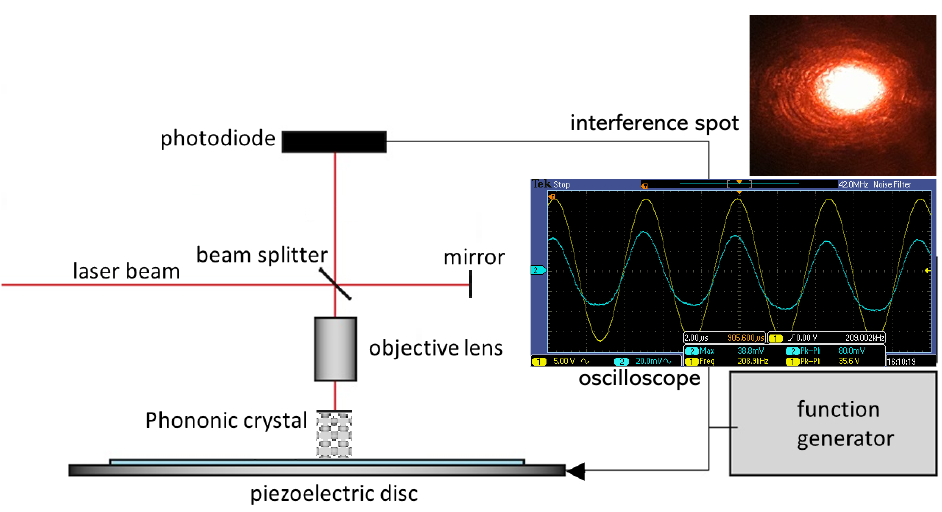
Figure 2. Michelson interferometer used to perform experimental tests on the three fabricated structures.